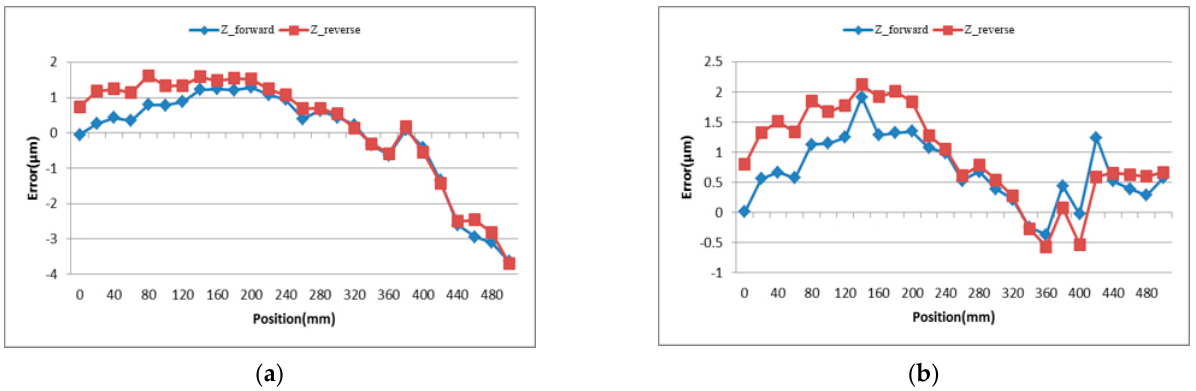
Figure 7. Compensation on the Z -axis: ( a ) results before compensation and ( b ) results after compensation.